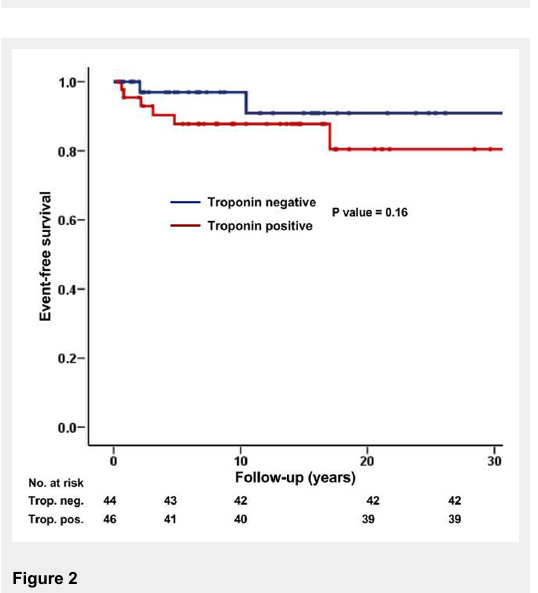
Kaplan-Meier analysis for estimation of event-free survival according to elevated (red line) or normal (blue line) hs-cTnT levels. Although patients with raised hs-cTnT levels showed a trend towards more events, it did not reach statistical significance (p =